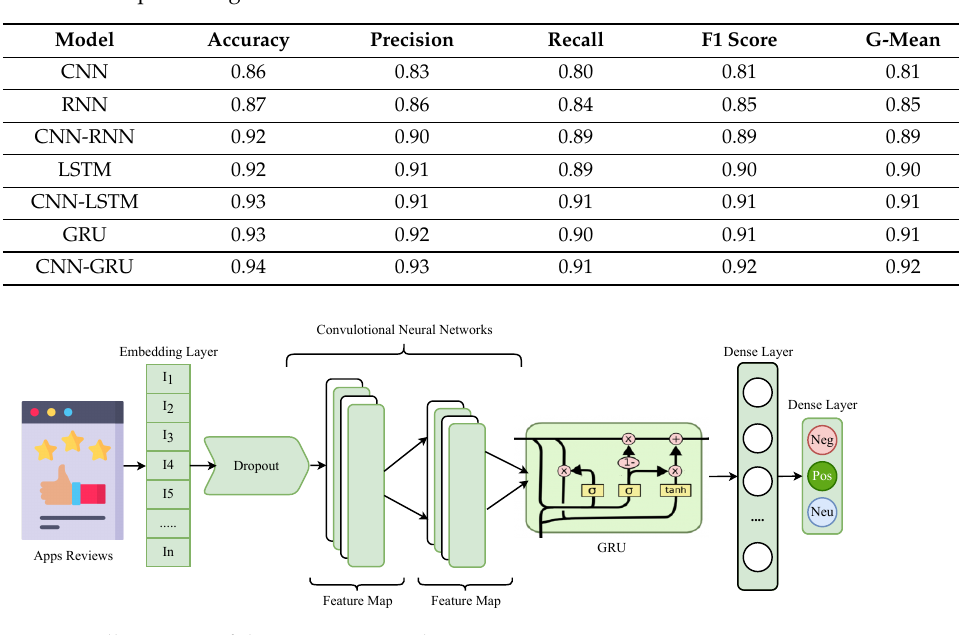
Figure 5. Illustration of the CNN-GRU